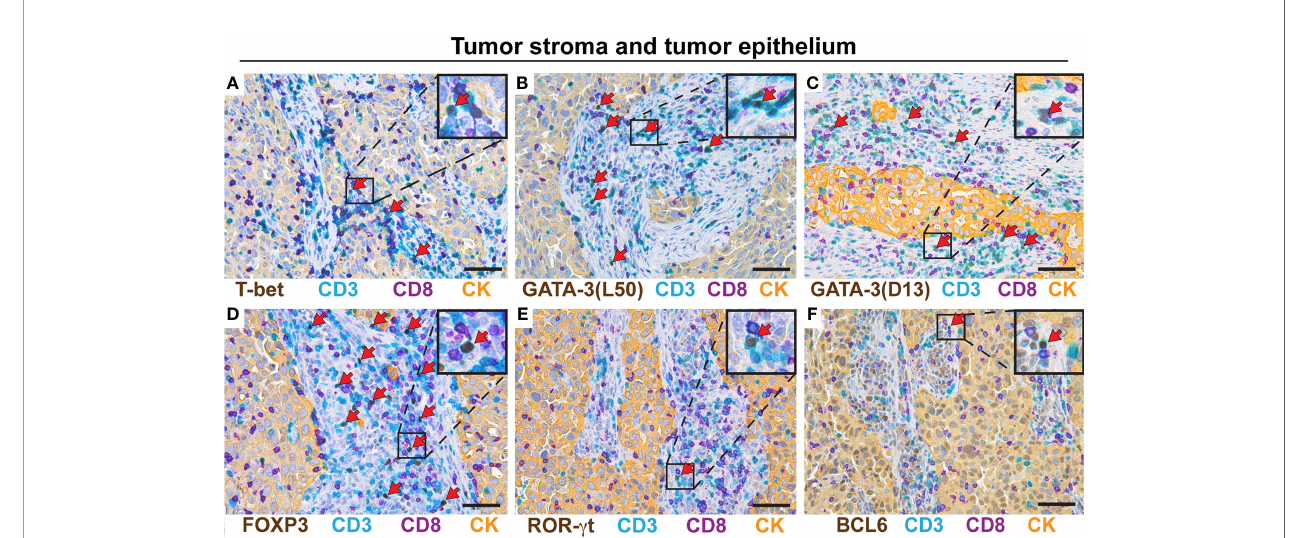
FIGURE 2 | Th2 and Treg cells predominate in NSCLC tumor stroma and epithelium. Representative images of stained serial sections from a primary lung adenocarcinoma tumor. Boxed areas are enlarged and presented as corner insets. T cells were stained with anti-CD3 (teal) and anti-CD8 (purple) mAbs, and CD3 + CD8 - cells were de fi ned as Th cells. Th cells were identi fi ed using mAbs speci fi c for subset-de fi ning transcription factors (brown). The positive cells for each Th subset (teal cells with brown nuclei) are indicated by red arrows. Immunostaining of cytokeratins (CK) was used to visualize the tumor epithelium that contains the carcinoma cells (yellow), and tumor stroma was de fi ned as cytokeratin-negative areas within the tumor border. (A) Th1 cells (T-bet + CD3 + CD8 - ). (B) Th2 cells (GATA-3 + CD3 + CD8 - ) identi fi ed by the anti-GATA-3 mAb clone L50-816 designated L50. (C) Th2 cells (GATA-3 + CD3 + CD8 - ) identi fi ed by the anti-GATA-3 mAb clone D13C9 abbreviated D13. (D) Treg cells (FOXP3 + CD3 + CD8 - ). (E) Th17 cells (ROR- g t + CD3 + CD8 - ). (F) Tfh cells (BCL6 + CD3 + CD8 - ). Original magni fi cation, 400x. Scale bars, 50 m m.